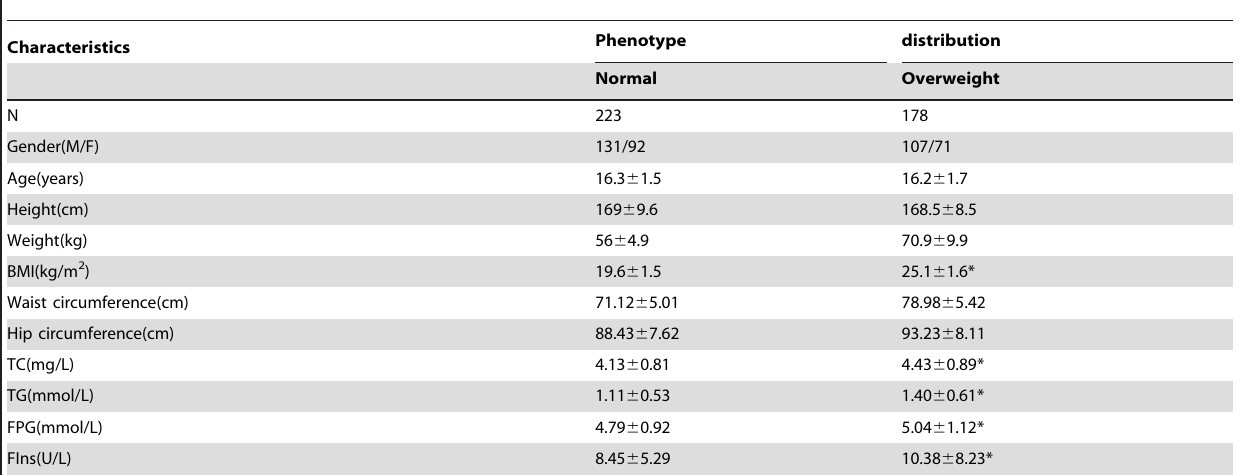
Table 1. General characteristic of the sampled adolescents by phenotype